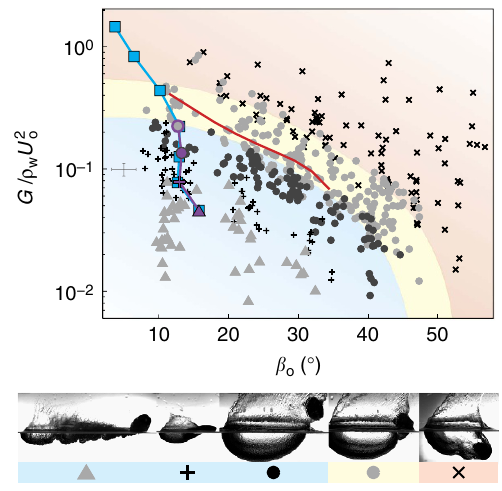
(cid:3) (cid:4) 1 = 2 U 2 for shallow w o Þ (cid:2) 5 = 12 (Fig. 3c), and o